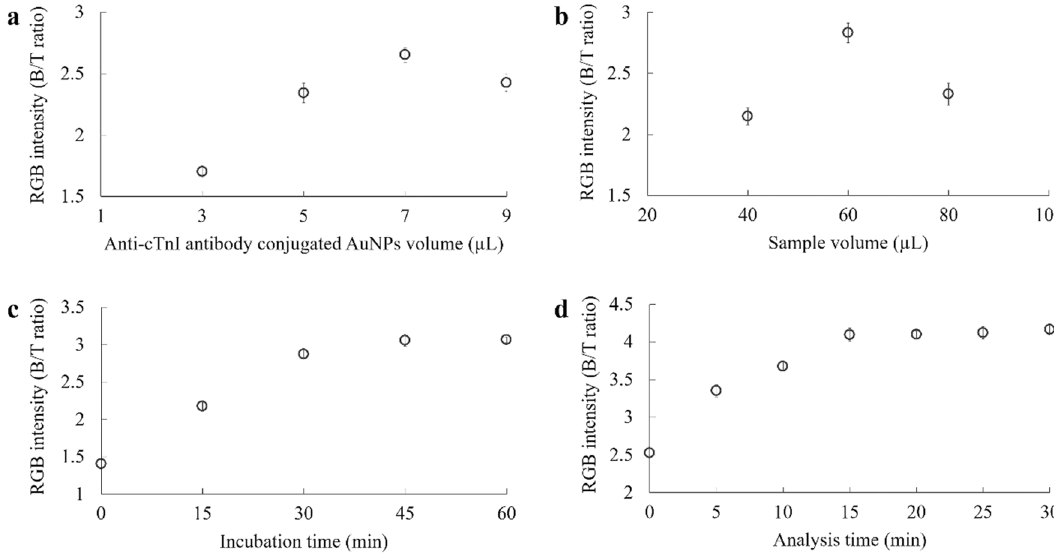
Figure 4. Optimization of various parameters which affect the dip strip immunoassay: ( a ) AuNP-Ab conjugate volume, ( b ) sample volume, ( c ) incubation time, and ( d ) analysis time. Data points represent the mean of three replicates (n = 3), error